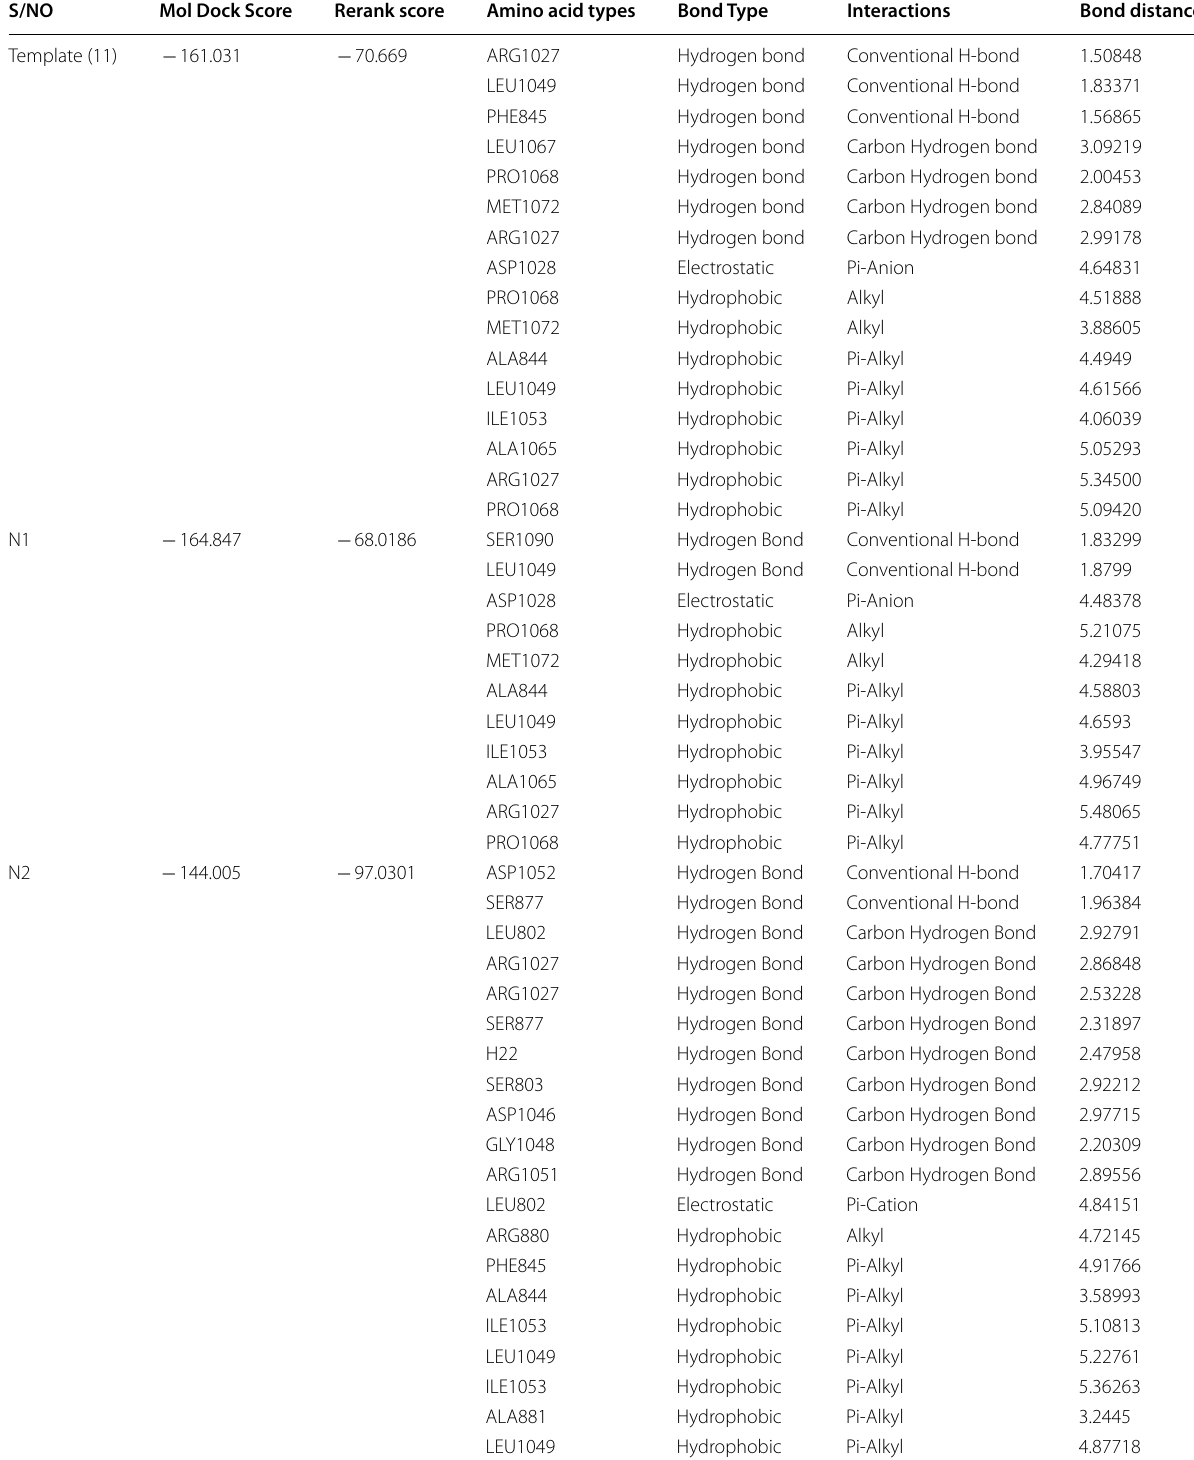
Table 6 Docking Results and various interactions of the template, the designed compounds and Sunitinib S/NO Template